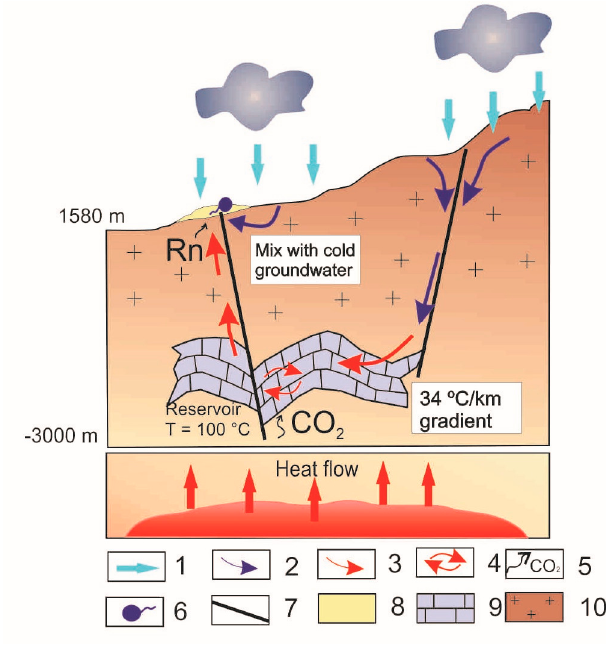
Figure 14. Conceptual model for the geochemical evolution of CO 2 -rich springs in the Choygan study area. 1—Rainfall; 2—Groundwater flow; 3—Thermal water flow; 4—Convection; 5—CO 2 flow; 6—